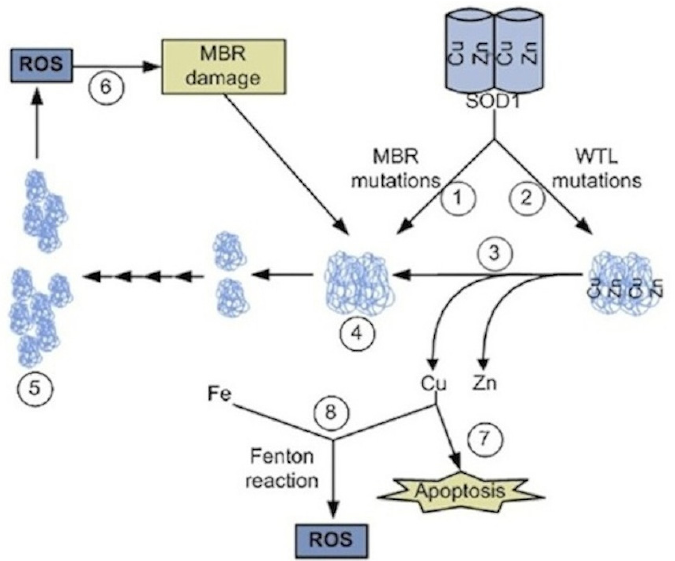
Figure 3. SOD1 structural changes and metal uncoupling in ALS: MBR and WTL-mutant SOD1 (1, 2) may promote metal uncoupling (3), protein aggregation (4, 5), oxidative damage (6) and apoptosis (7) (Source: Rivera-Mancía et al.